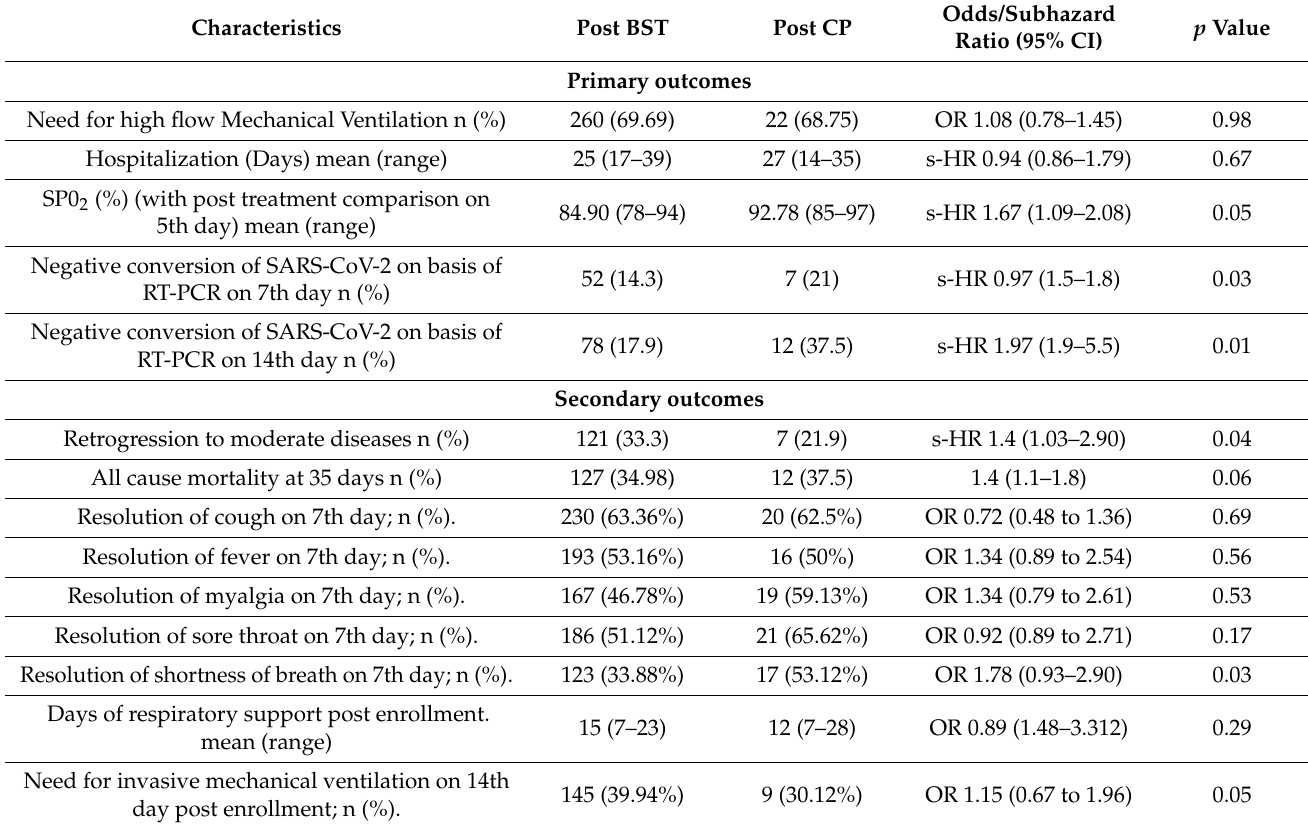
Table 5. Comparison of primary and secondary outcome in best standard treatment arm and convalescent plasma